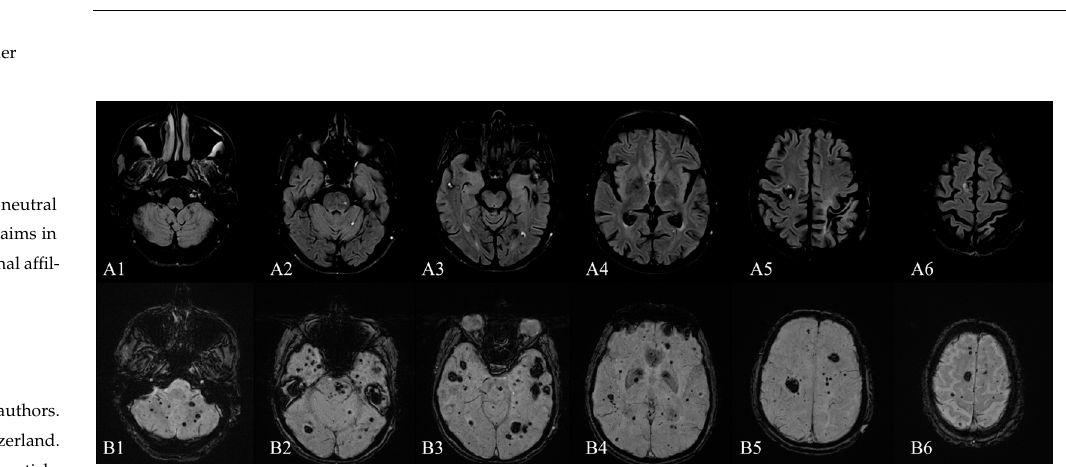
Figure 1. Brain MRI (1.5 T)—December 2015: ( A1 – A6 ) axial FLAIR sequence and ( B1 – B6 ) axial SWI sequence (TE 40.00 ms) showing multiple infra- and supratentorial, bilateral, cavernous malfor- mations (lesions in the order of tens), without recent signs of bleeding. The characteristic MRI ap- pearance of CCMs consists of well-circumscribed “popcorn-like” lesions of different sizes with a mixed-signal intensity core and a hypointense peripheral rim of hemosiderin conferring a “bloom- ing” effect [1–3]. This heterogeneous appearance is due to the presence of blood products in various stages of degradation [4]. Cavernous malformations are present in 0.3–0.5% of the general popula- tion, although some postmortem studies suggest that this number could be higher, up to 4% [1,5]. In most cases, they occur in sporadic forms (80%), usually with solitary lesions, but familial cases have also been reported. Familial cases usually present with multiple, congenital, and acquired le- sions, in various locations: cerebral, spinal, retinal, and cutaneous [6–8]. Topographically, the ma- jority of CNS cavernous malformations have a supratentorial localization (76%), followed by infra- tentorial regions (19%), the spinal involvement being seldomly encountered (5%) [9]. Furthermore, concomitant lesions at all of the three levels are exceptionally rare and they are a particularity of the familial forms of cavernous malformations [10,11]. Clinically, the majority of cerebral cavernous malformations (CCMs) become symptomatic between the second to fifth decades with findings such as seizures (23–50% of cases), headaches (6–52%), focal neurological deficits (20–45%) or hemor- rhages (9–56%) [2,9,12]. Up to 40% of patients with such malformations are asymptomatic [12]. Im- aging-wise, T2-weighted, gradient-echo MR (T2-GRE), high-field MR and especially susceptibility- weighted (SWI) MR sequences are the most sensitive techniques for detecting CCMs [1,13]. Here, we present the case of a 65-year-old man diagnosed in 2015 in our clinic with multiple supra- and infratentorial CCMs (Figure 1), whom we were following for secondary epilepsy with rare seizures with focal onset, impaired awareness, and secondary generalization. He used to take carbamaze- pine, but he had discontinued the treatment for the last three years despite our recommendations. More recently, he had been receiving a direct-acting oral anticoagulant indicated by the cardiologist as primary prophylaxis of cardioembolic stroke from atrial fibrillation with a CHA 2 DS 2 -VASc score of 2. Recently, in 2021, the patient was re-admitted into our clinic, this time for postural instability and motor deficit with gait impairment, with the onset three days prior. The initial neurologic ex- amination showed temporo-spatial disorientation, hypophonia, right-side central facial paresis, asymmetric tetraparesis (force grading on the MRC scale of 4/5 in the upper limbs and 3/5 in the lower limbs), with the right side slightly more affected, upper limbs dysmetria, brisk deep tendon reflexes with Babinski sign, abnormal ataxic gait, which was possible for only a few steps with bi- lateral support. We also noted a significant cognitive decline from MMSE of 23 points in 2015 (mainly due to attention, orientation, and executive functions deficits) to severe dementia with a MMSE of 8 points in 2021, when the patient presented significantly slowed behavioral reaction time with failure to initiate Trail Making Test part B, reasoning difficulties and forgetfulness.